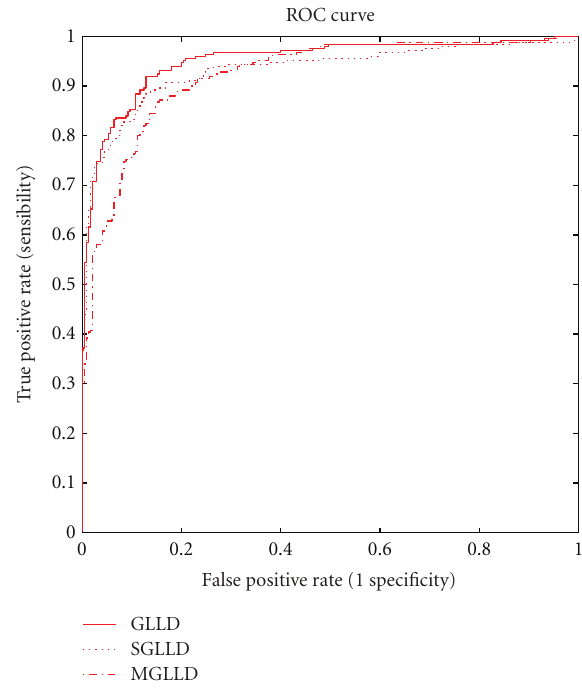
Figure 10: ROC curve corresponding to a subset of 1000 ROIs images from the DDSM